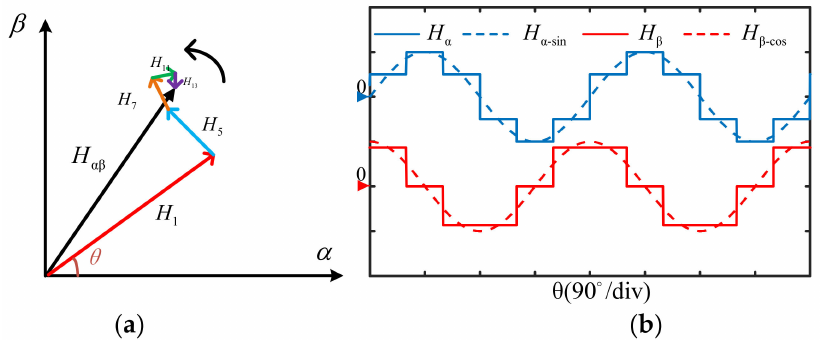
Figure 7. ( a ) The Hall position vector decomposition; ( b ) The fundamental components of H α , H β . When the components of the input are known, the low-order harmonics can be reduced by using harmonic feedback decoupling. The improved observer structure is shown in Figure 8. According to the phase angle at the moment, the 5th, 7th, 11th and 13th harmonics are directly calculated and fed back to the input. The low-order harmonics are subtracted from the input, and the remaining high-order harmonics can be well suppressed by the low-pass filtering characteristic of the observer. The function of feedback decoupling is to further increase the gain of the observer, reduce the low-frequency noises of the input, and obtain a better dynamic performance while reducing the error of rotor position estimation